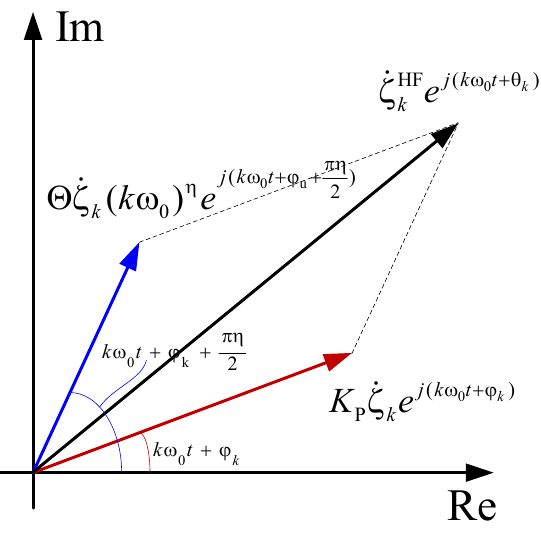
Figure 3. Calculation process in the complex plane.